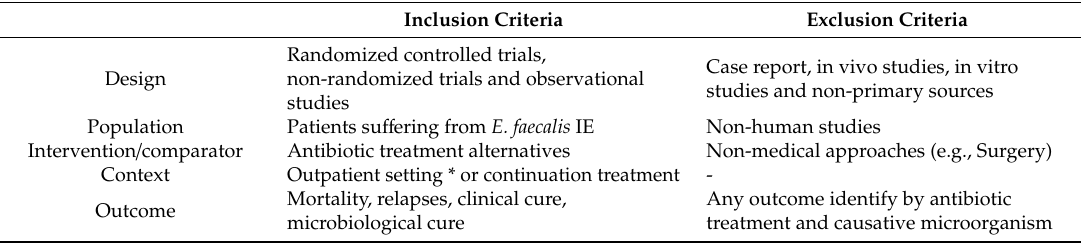
Table 3. Eligibility